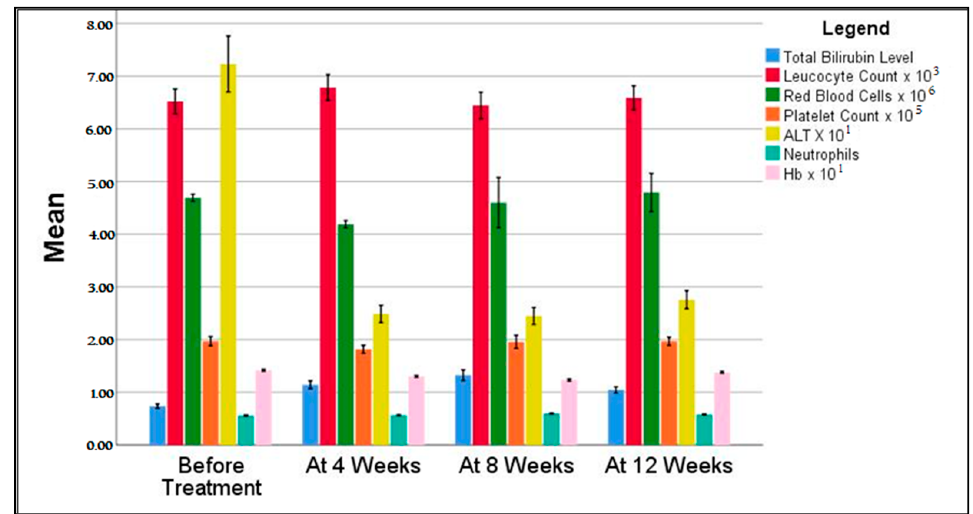
Figure 2. Evolution of blood tests during treatment. Average laboratory values of patients involved in the study were evaluated in a follow-up scheme, with a total of 4 measurements. Hb = Hemoglobin; ALT = Alanine Aminotransferase.